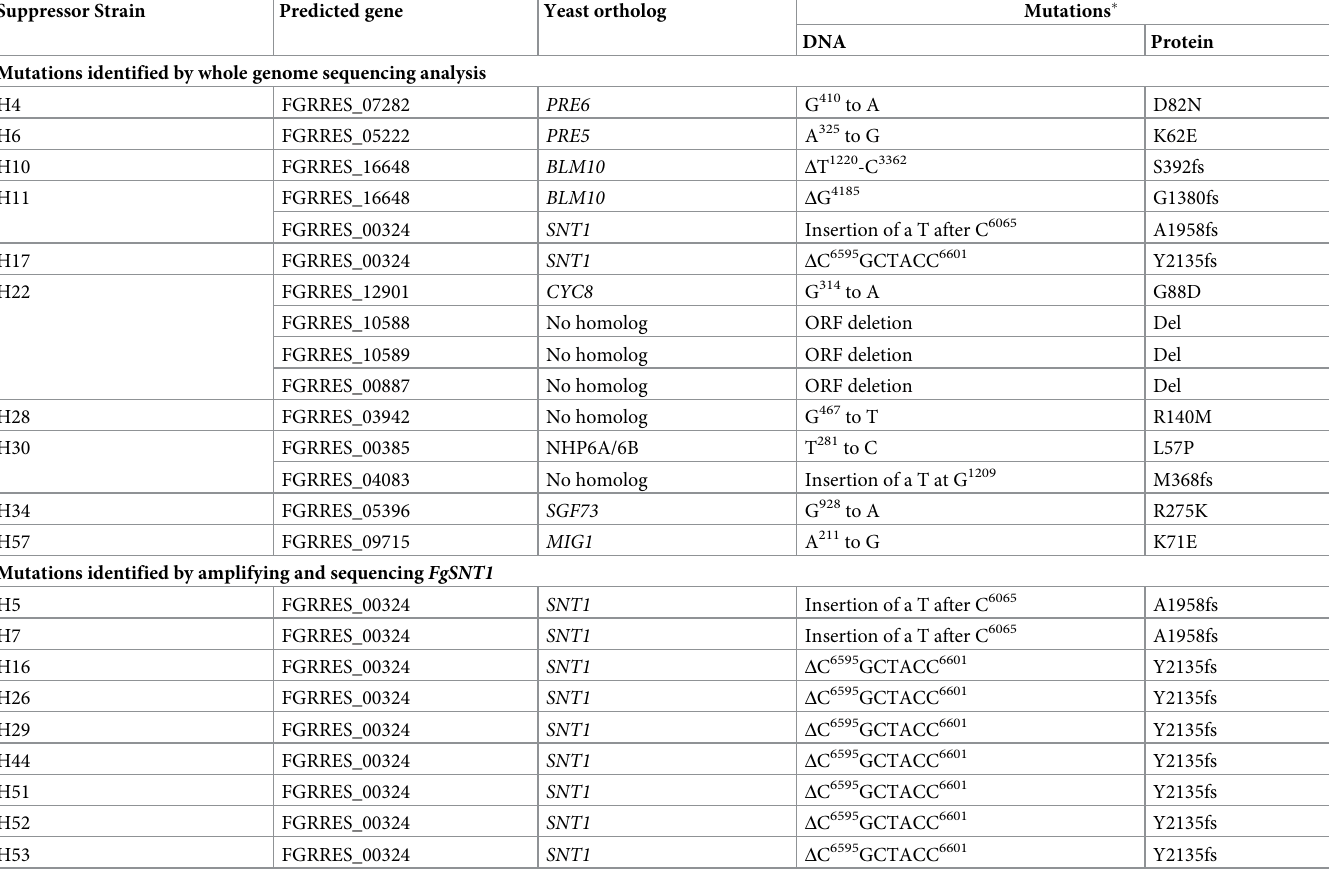
� Mutations identified in the DNA sequence of predicted genes resulting in changes in amino acid sequences. fs, frameshift